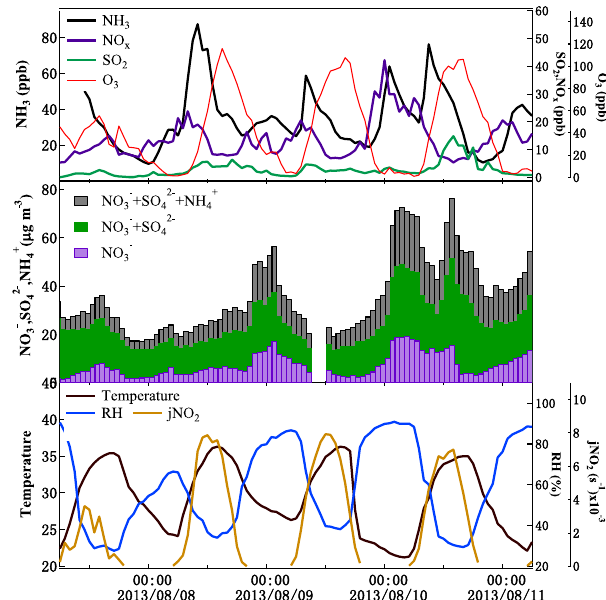
Figure 9. Hourly concentrations of gaseous species, ionic species, and j NO 2 measured in the pollution episode during 7–11 August